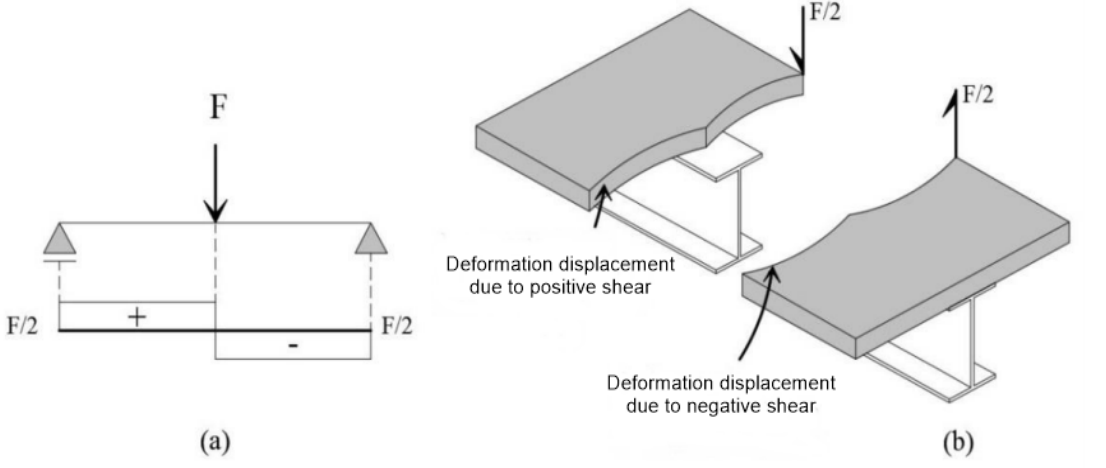
Figure 2. Displacements due to incompatible deformations. Adapted from Reginato [16].